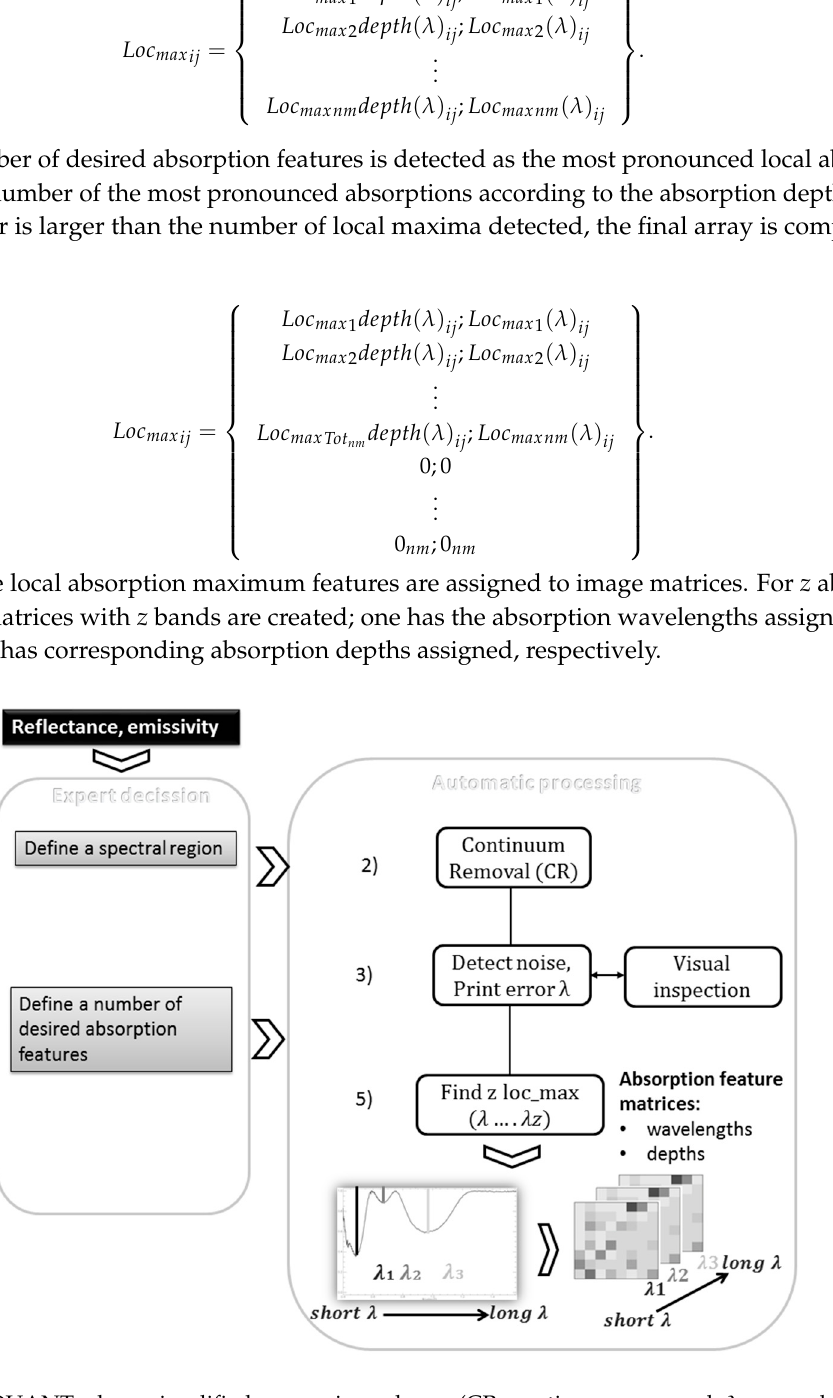
Figure 2. QUANTools: a simplified processing scheme (CR: continuum removal, λ: wavelength loc_mac: local absorption feature maximum). The detected absorption feature parameters are sorted in ascending order by wavelength ( λ 1, λ 2 − λ z )